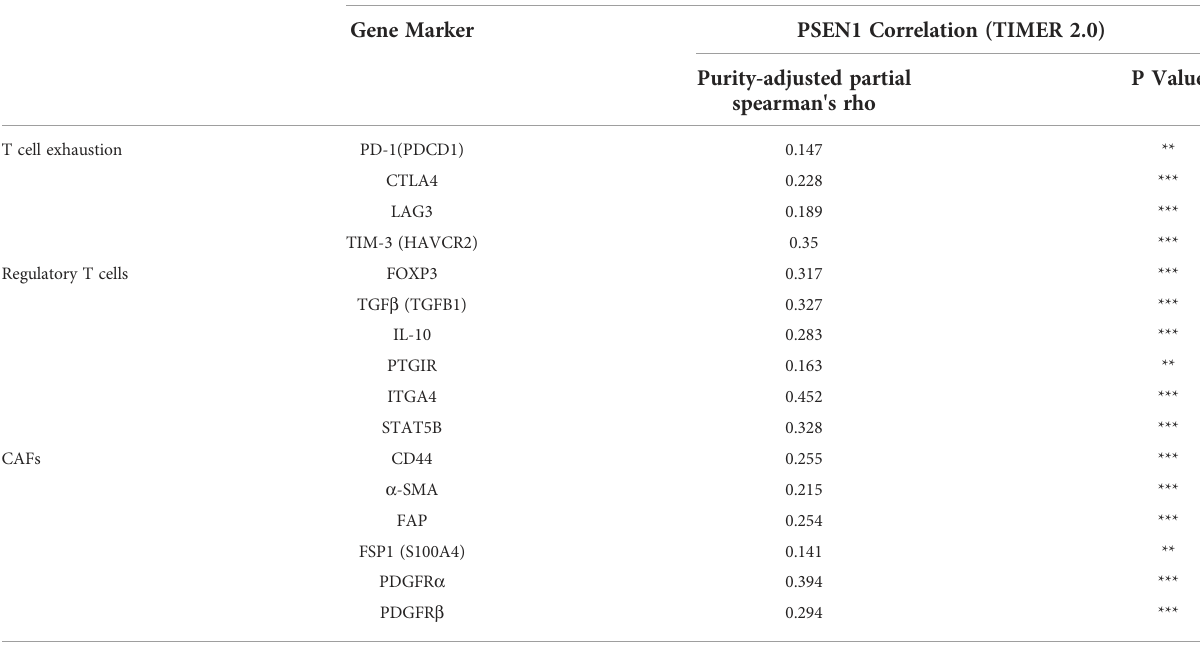
TABLE 3 Correlations between PSEN1 and the Gene Markers of the Immune Subsets determined by TIMER2.0.